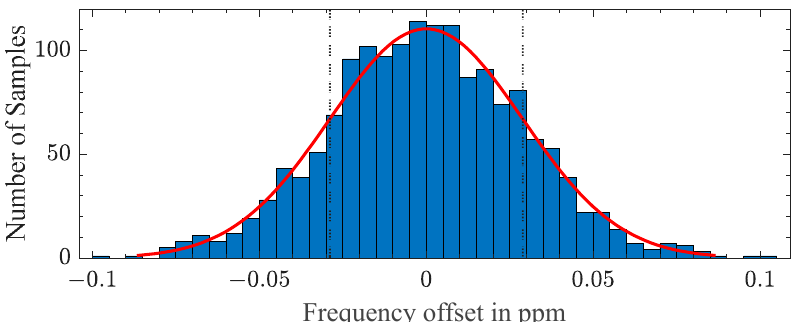
Figure 9. Histogram of 1600 temperature measurements at a constant temperature with a normal distribution fit. The precision of the measurement could be enhanced by the averaging of the samples. Averaging over four samples led to a standard deviation of 3.2 mHz at a measurement duration of 1 s. The obtained sensitivity shown in Figure 7 and the standard deviation shown in Figure 9 demonstrated the short time precision of the wireless temperature measurement with a resolution of less than 1 mK. To transform this short time precision into robust accuracy, a careful calibration of the system would be needed, together with further investigations into the clock stability of the readout unit over time and temperature changes and the aging of the resonant sensor. Additionally, the effects of an axial offset of the two transducers are shown in Figure 10. Here, one transducer was bonded to a 15 mm thick CFRP plate with silicone rubber, and the second transducer was acoustically coupled with non-permanent glycerin and placed 2 mm away from its previous position for each measurement. We compared a measurement of